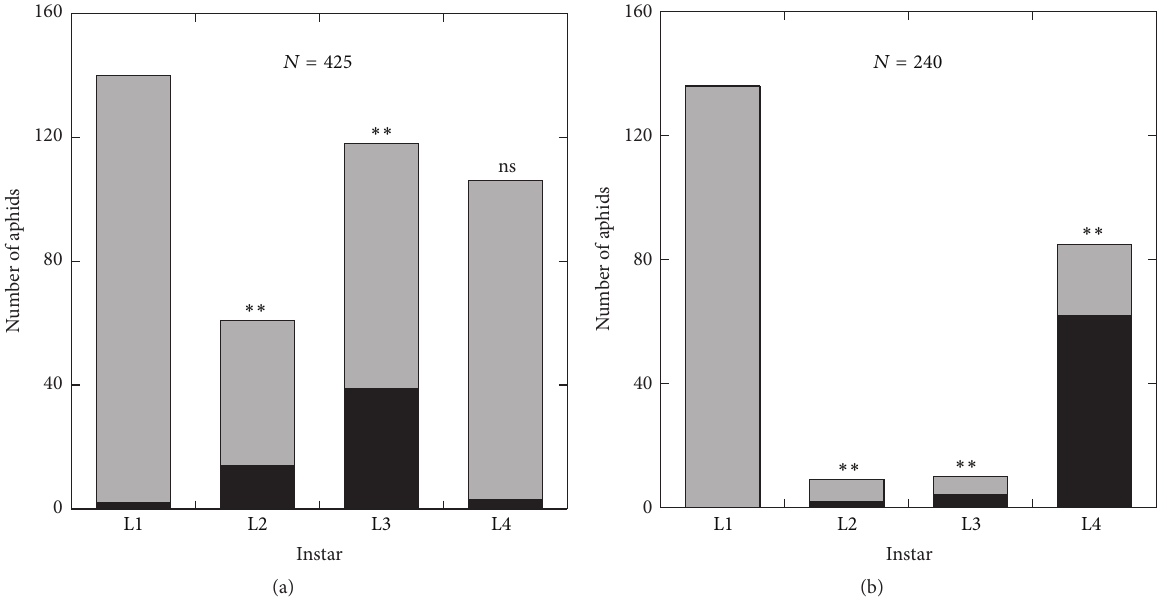
Figure 9: Number of the first- to the fourth-instar nymphs with (indicated by black) or without (indicated by grey) the next-instar cuticle developing inside. (a) Colony Exp#1 (29 September 2015); (b) colony 14160 (10 October 2014). L1, L2, L3, and L4 denote the first-, second-, third-, and fourth-instar nymphs, respectively. Significant differences ( 𝑝 < 0.01 ) in the molting rate between the first instar and the remaining three instars are indicated by double asterisks above each column (Fisher’s exact test with Holm’s correction).